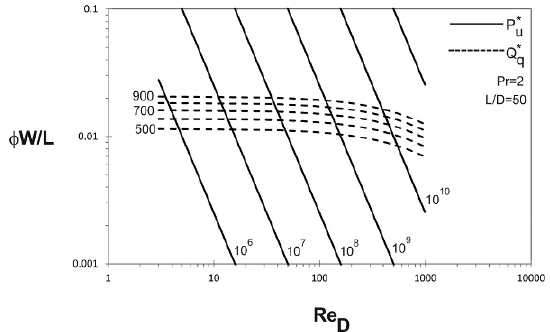
Figure 9. Influence of the Prandtl number on the variation of L/D group with the Reynolds number (laminar regime and pre- scribed wall temperature boundary)